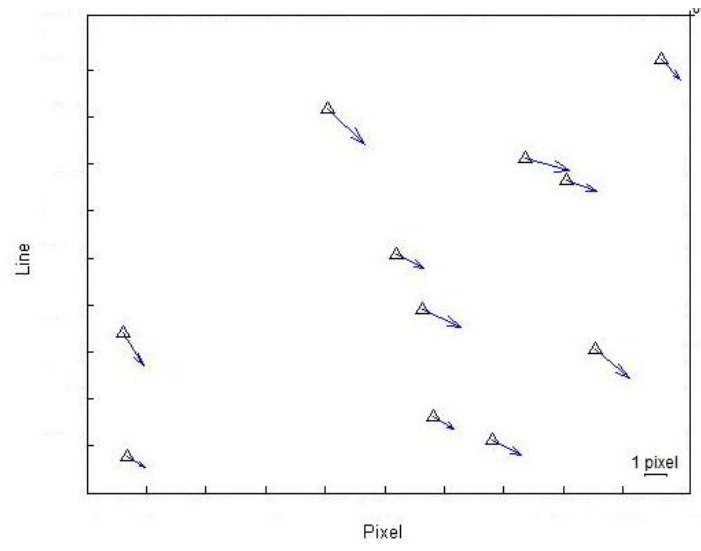
Figure 5. Discrepancies in the image space between the calculated rational polynomial coefficient (RPCs) and the true ground control points